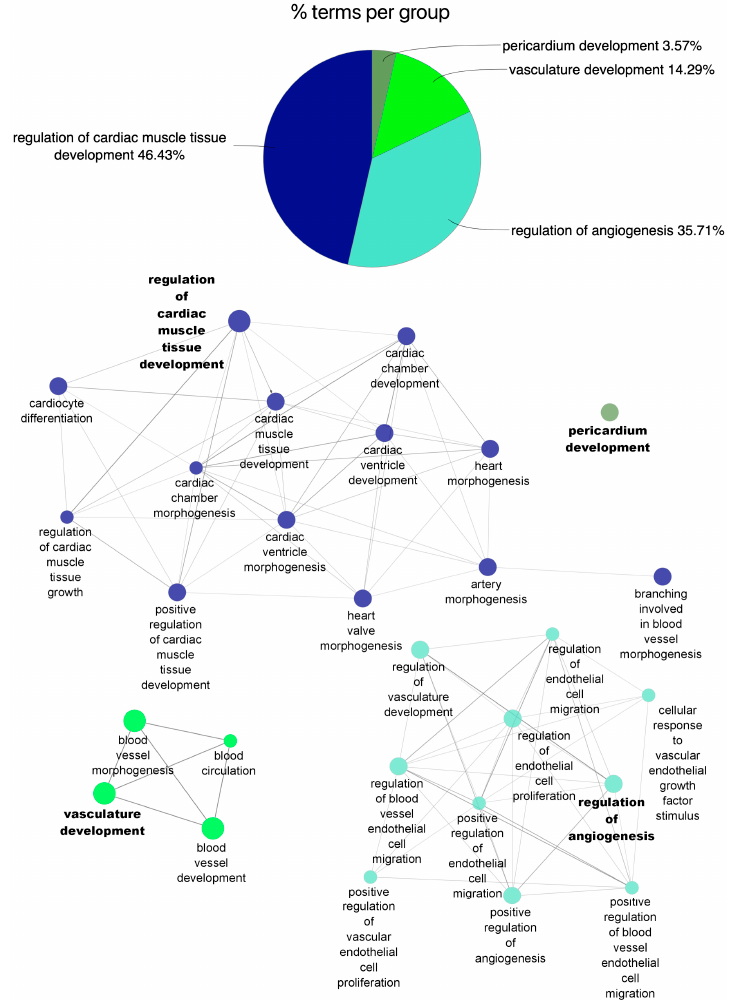
Figure 4. Functional enrichment of miRNA profile and associated biological process after 1 year after acute myocardial infarction (Follow-up). The pie chart plots the percentage of miRNA-associated functional biological processes that were significantly modified ( p < 0.05, log2 FC ≥ 1/ ≤− 1) in Follow-up group. Overrepresented Biological Process Gene Ontology (GO) terms are represented as nodes, and node size represents term enrichment significance by Bonferroni test ( p <